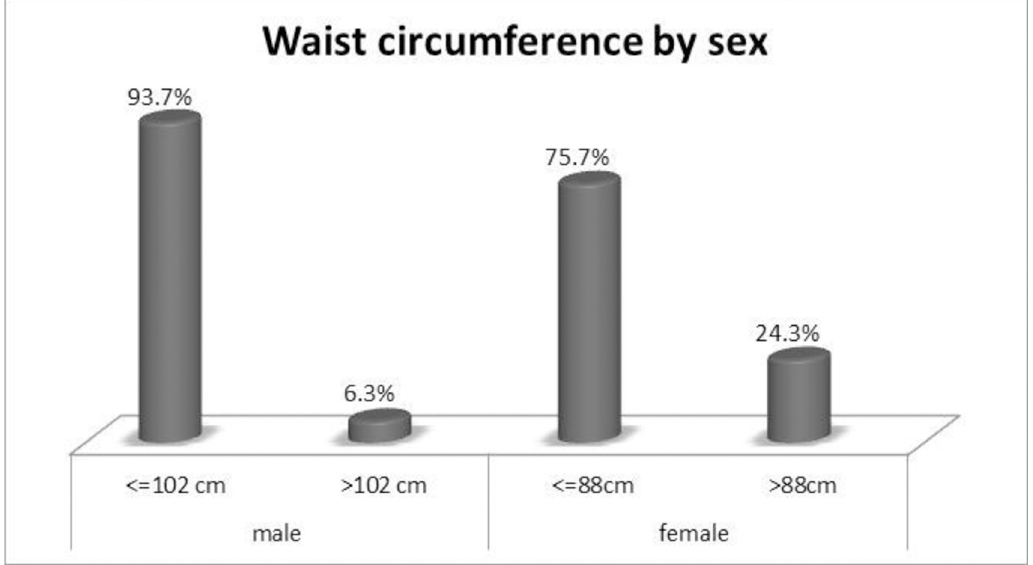
Fig 3. Waist Circumferences by sex among adults population in Woldia town, Northeast Ethiopia, 2020.